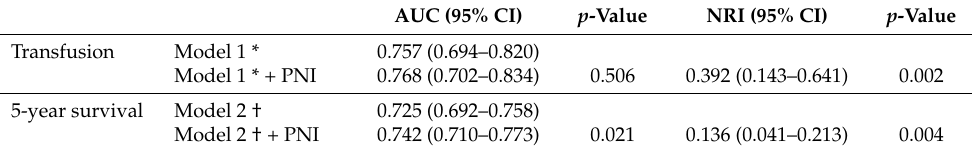
Table 5. Improvement in the AUC and NRI by adding PNI to the clinical predictive